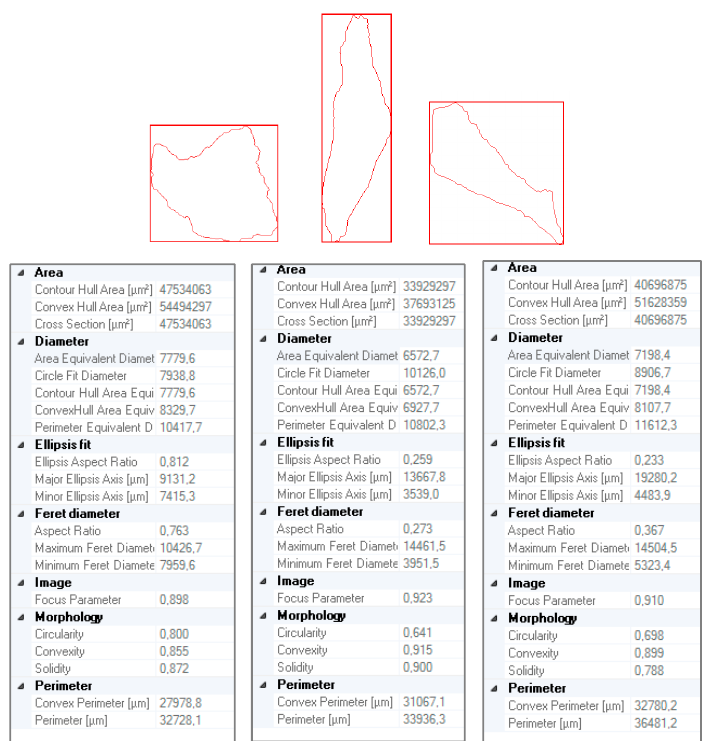
Figure 10. List of determined geometrical parameters for selected irregular particles of chalcedonite.